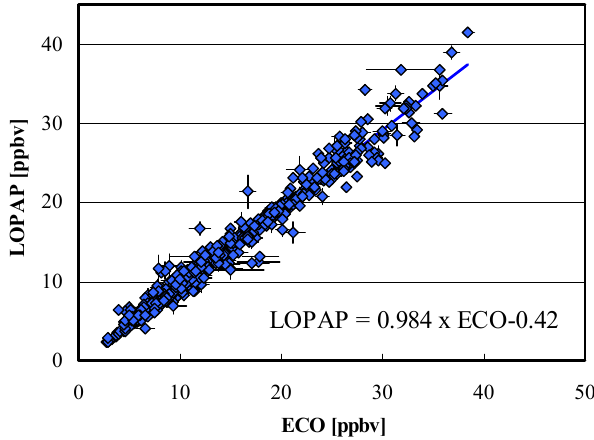
Fig. 10. Correlation of all 5 min averaged NO 2 data of the NO 2 -LOPAP against the Eco-Physics instrument. The error bars represent only the precision of the instruments. A weighted orthogonal regression analysis was used, for which the errors of both instruments were considered (Brauers and Finlayson-Pitts, 1997).